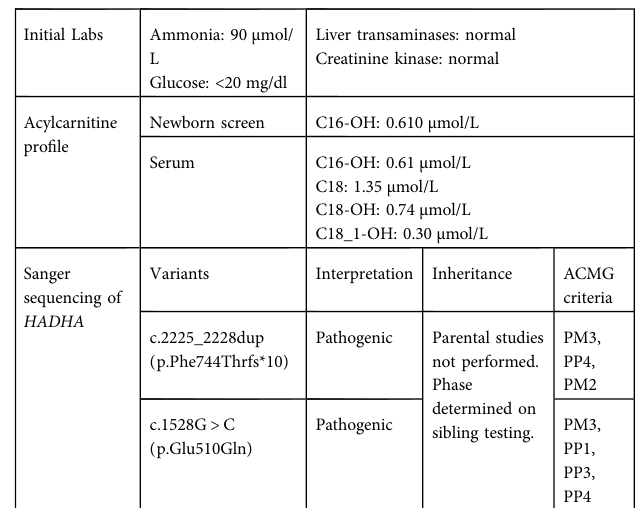
TABLE 1 Initial biochemical and molecular lab